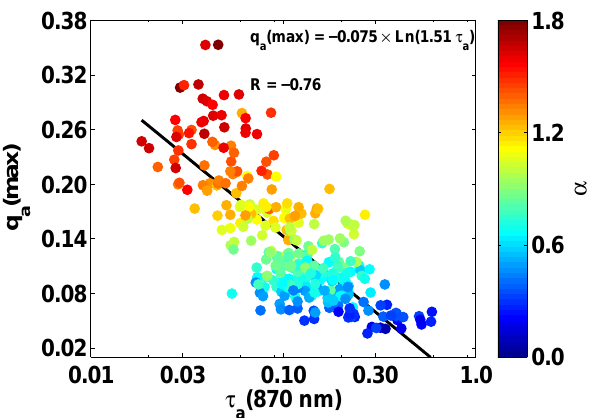
Fig. 7. Variations of q a ( max ) versus τ a (870nm) on the logarith- mic scale. Colors are mapped to α in linear scale, February 2010 to December 2012, IASBS site.